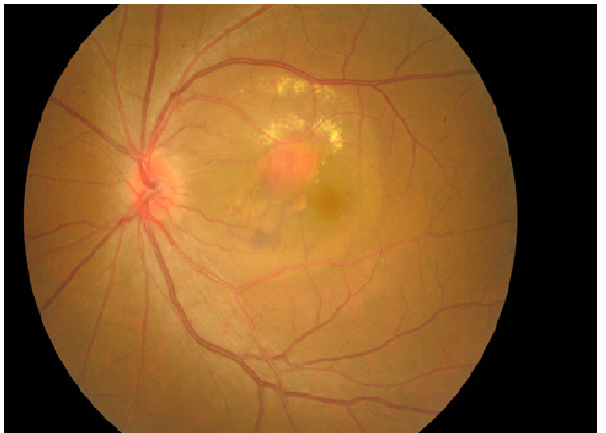
Figure 3. A 51-year-old Vietnamese male patient with PCV with a typical orange-red nodule, hard exudates, and fluid around the nodule in the left eye.